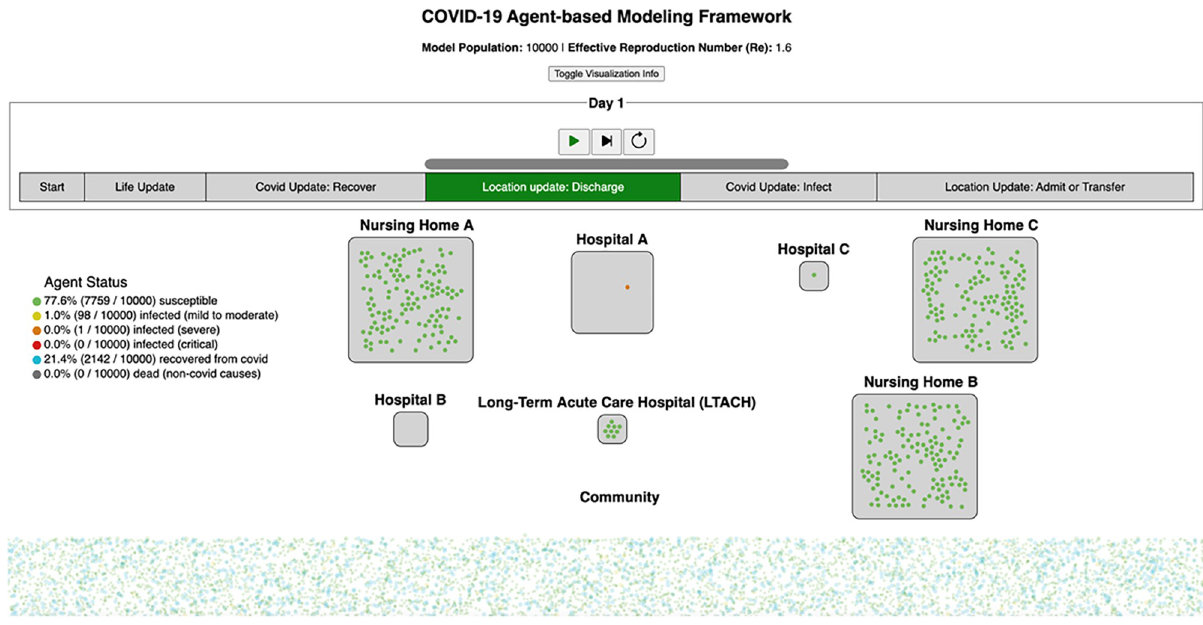
Fig 3. Screenshot of the COVID-19 ABM animation at hospital